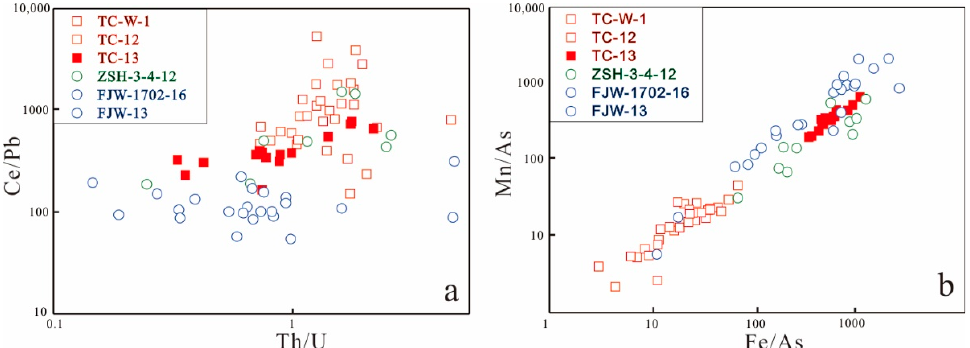
Figure 7. The apatite trace element ratios diagram in the Dexing deposit, ( a ) Ce/Pb vs. Th/U; ( b ) Mn/As vs. Fe/As.